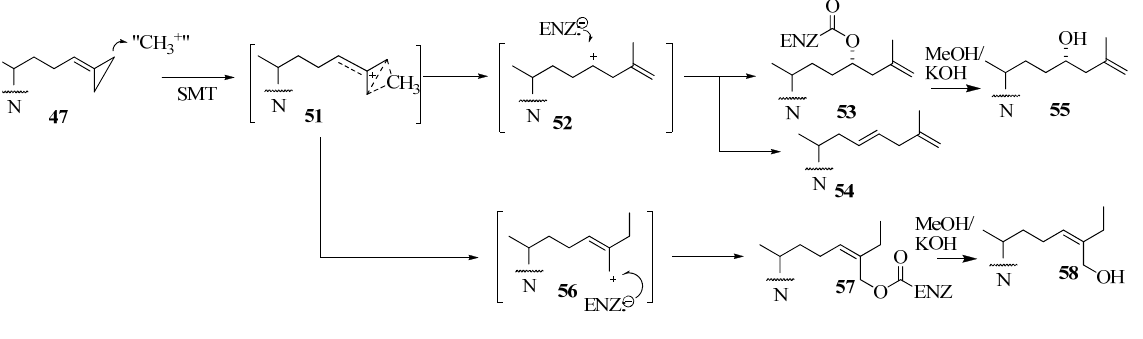
Figure 9. Proposed C24-alkylation pathway of 26, 27-dehydrozymosterol catalyzed by